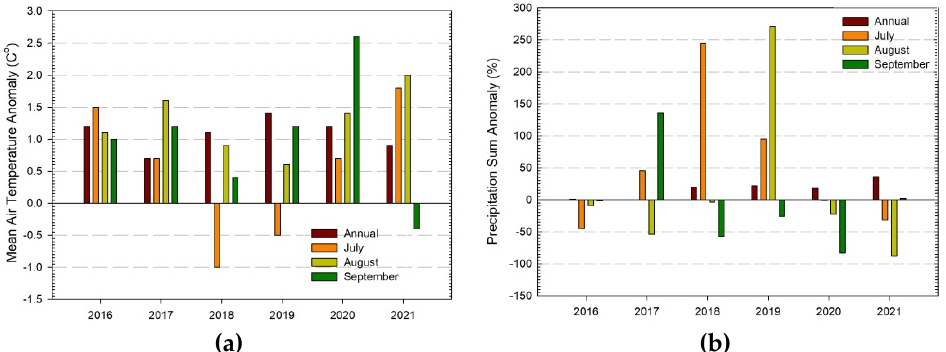
Figure 2. Mean air temperature ( a ) and precipitation sum ( b ) anomalies for the period of 2016–2021 on an annual basis and for the summer months (July, August, and